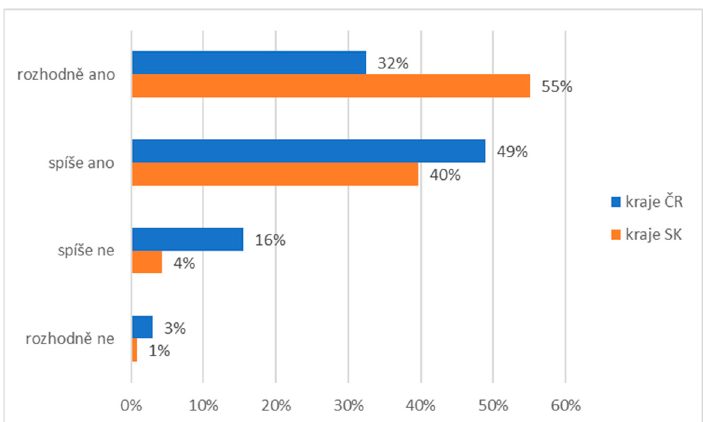
Figure 8. Descriptive statistics of the participants’ subjective perception of participation of the church in social and pastoral service (comparison of the healthy population of eastern Slovakia and north-western Czech Republic). Legend: CZ—healthy population of north-western Czech Republic, SK—healthy population of eastern Slovakia. Source: own resource.